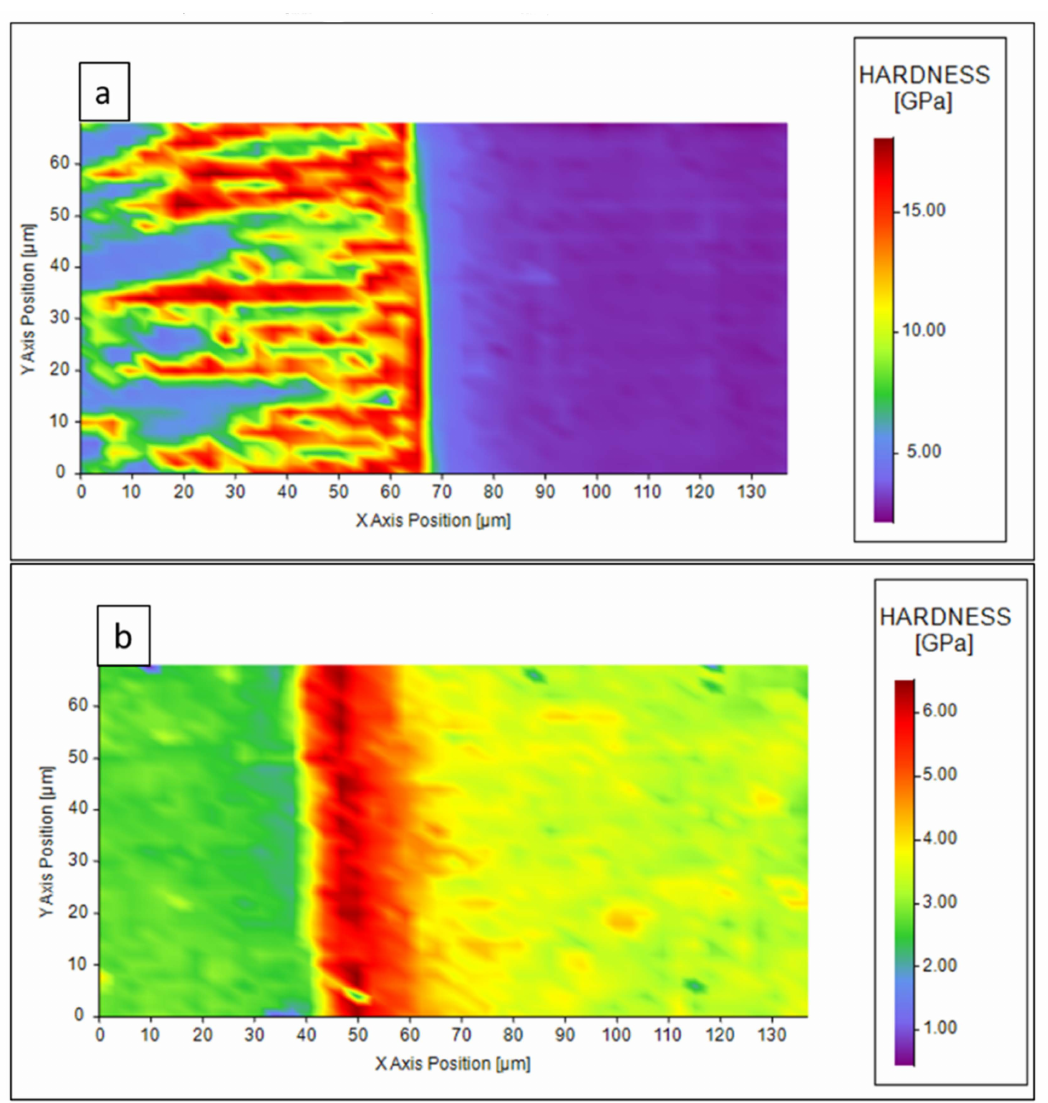
Figure 14. Nanohardness maps. ( a ) The V/IN718 interface. ( b ) The V/CpTi